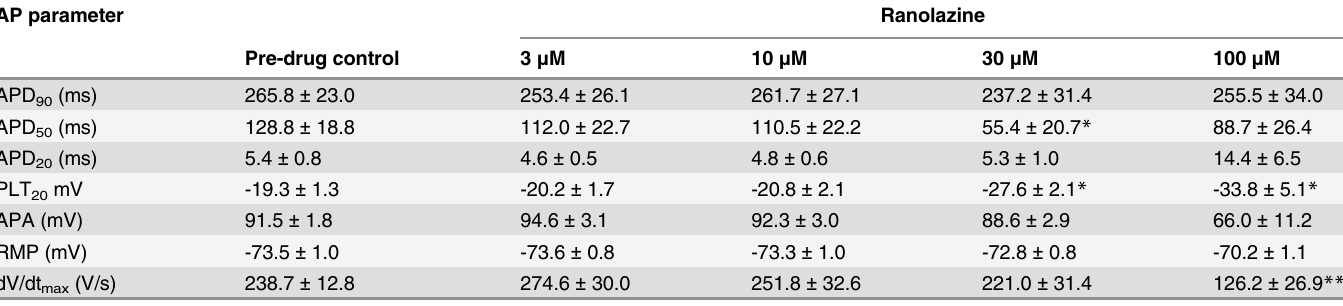
Table 2. Effects of ranolazine on human right atrial action potential parameters (1 Hz) from patients in sinus rhythm (SR), n = 6. AP